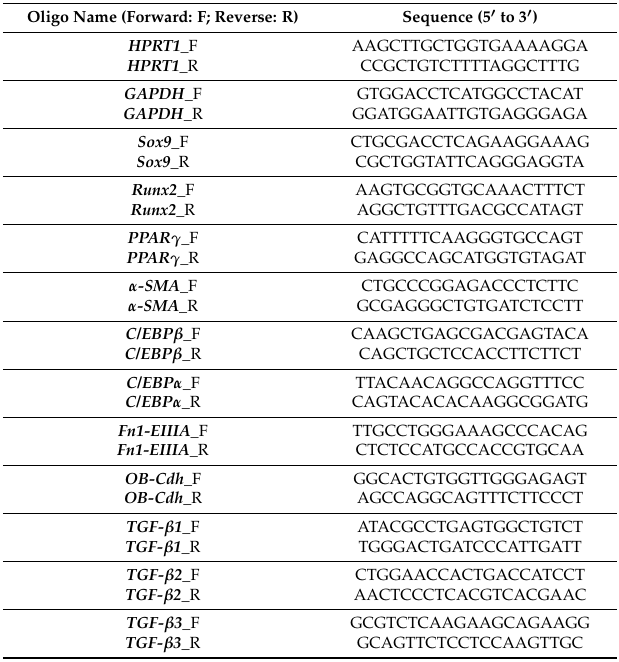
Table 1. RT-qPCR Primer